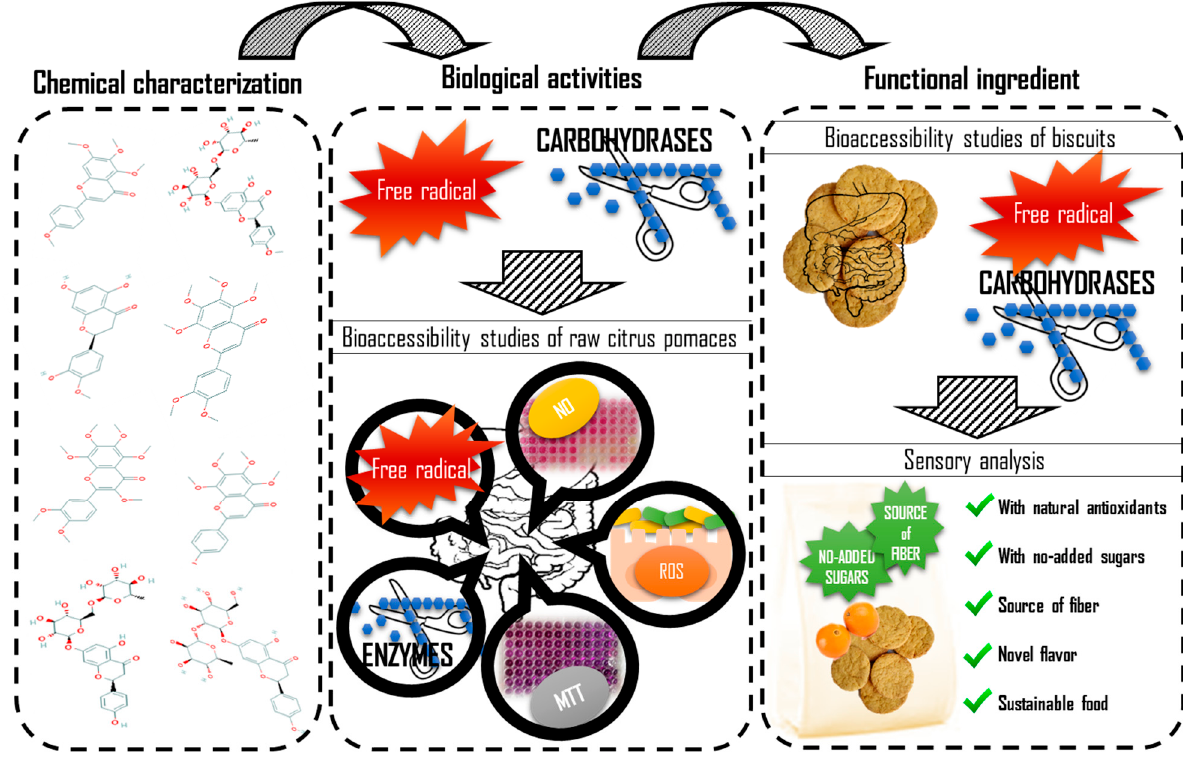
Figure 7. Scheme of the steps followed in the current